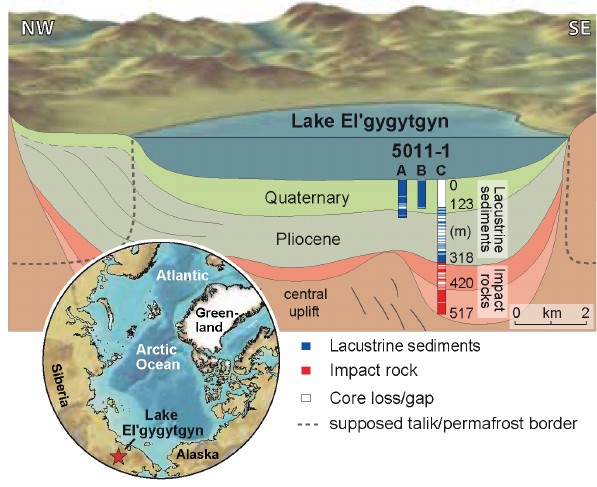
Fig. 1. Location of Lake El’gygytgyn in north-eastern Russia (in- serted map) and schematic cross-section of the El’gygytgyn basin stratigraphy showing the recovery of holes A, B, and C at ICDP Site 5011-1 (modified after Melles et al.,